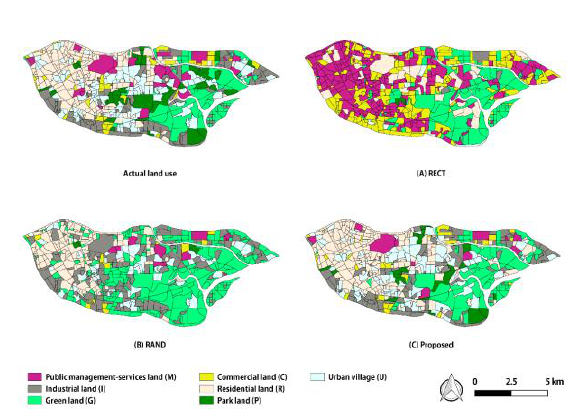
Figure 6. Urban land-use classification results for the different methods: (A) RECT, (B) RAND, (C) Proposed